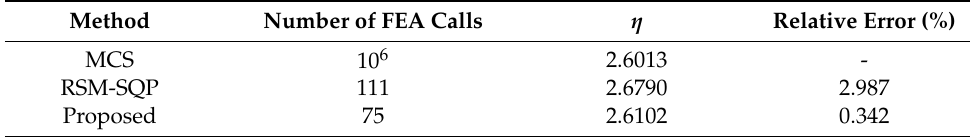
Table 8. Result comparison using different methods for Example 4.